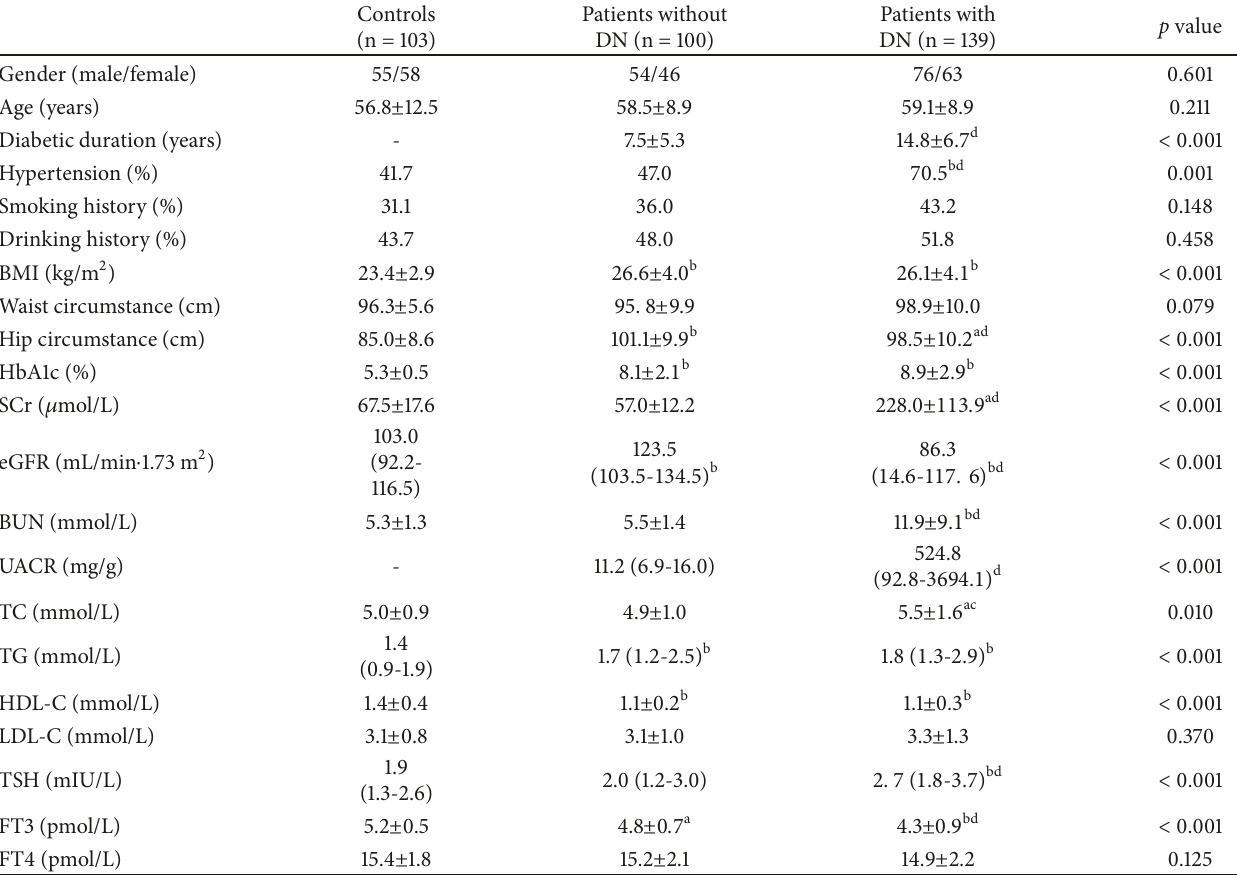
Table 1: Comparisons of clinical characteristics between controls, patients without DN, and patients with DN.